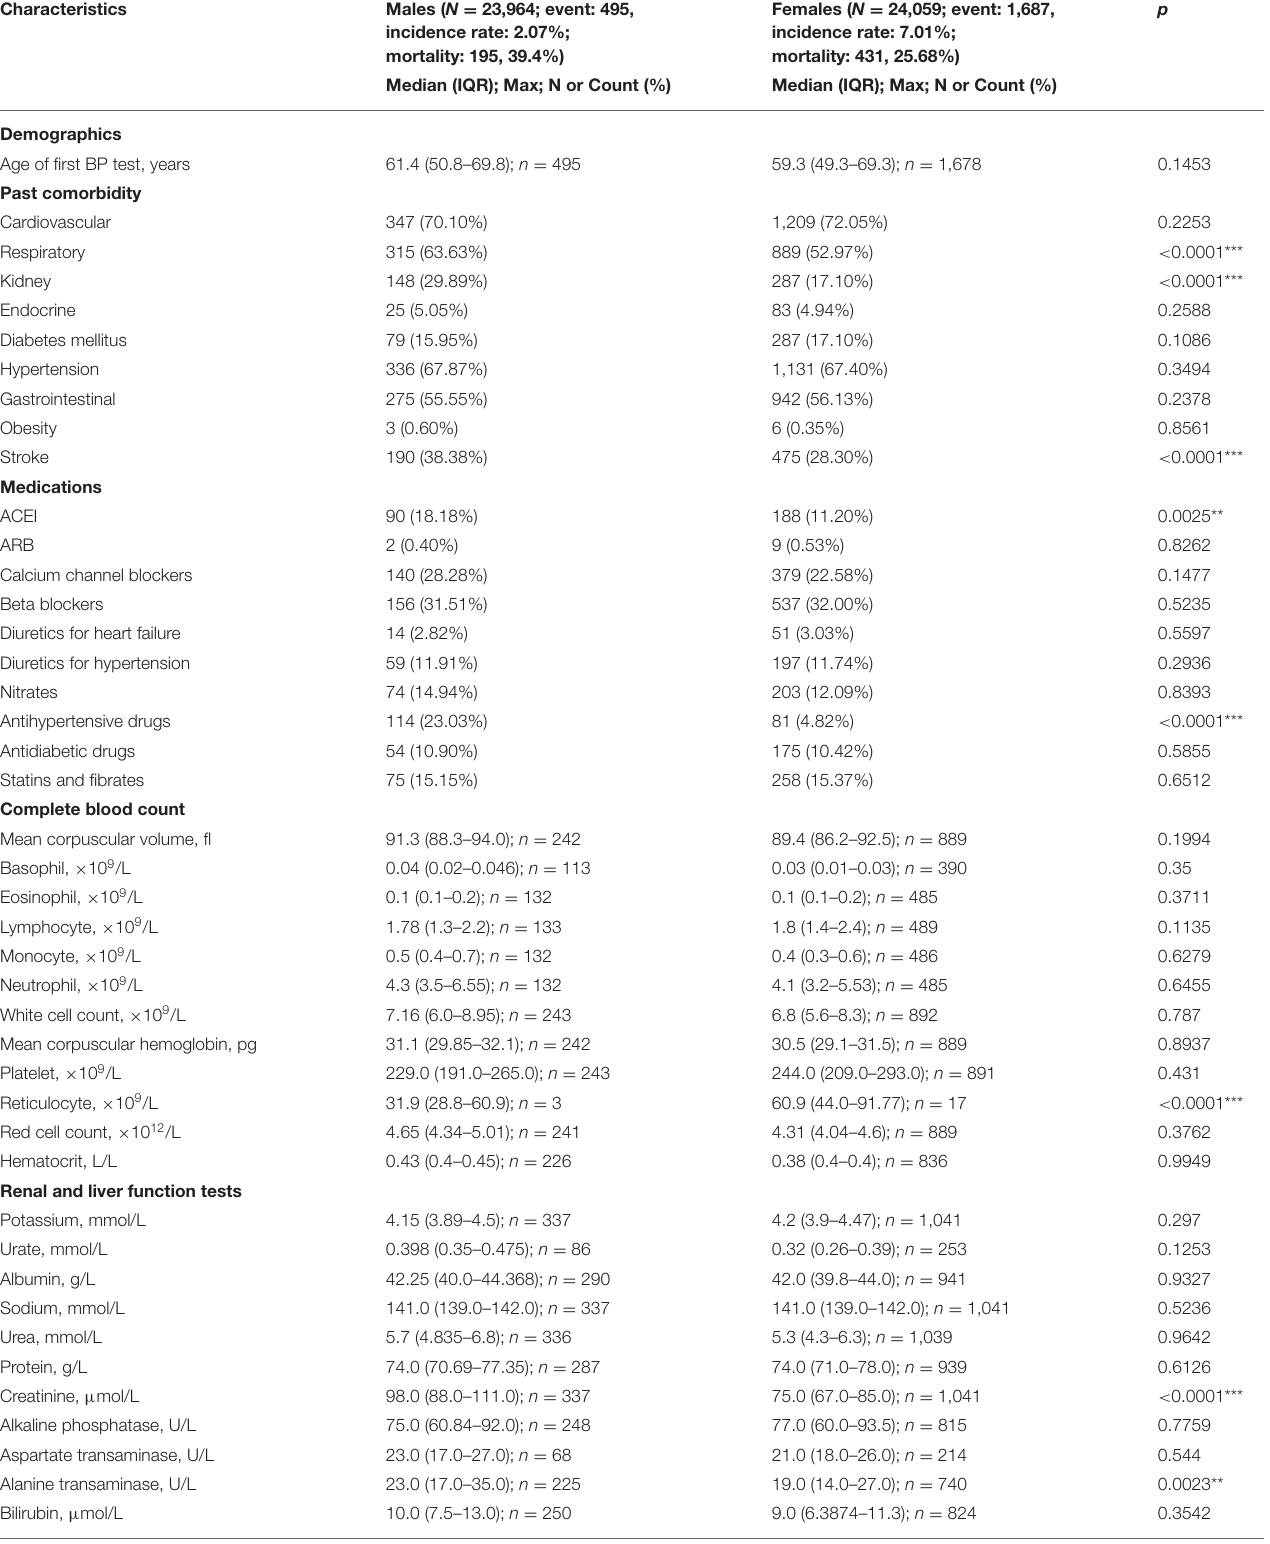
TABLE 1 | Clinical characteristics of patients included in this cohort. Characteristics mortality: 195, 39.4%) mortality: 431,